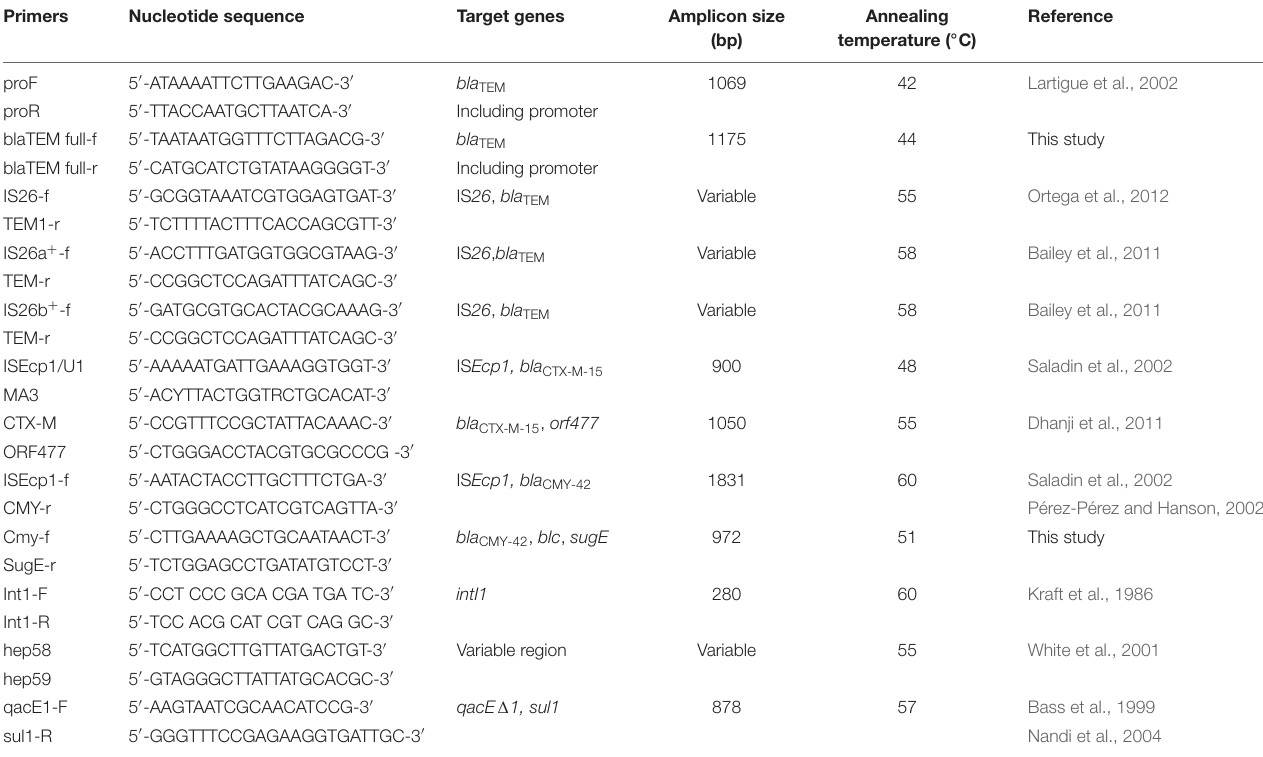
TABLE 1 | Details of target genes, primers, annealing temperatures, and their amplicon size.